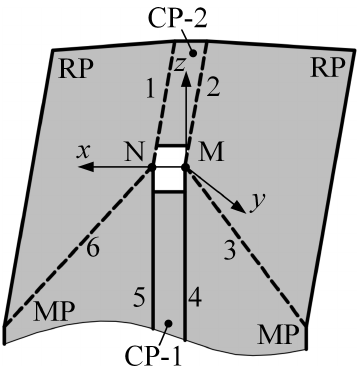
Figure A1. Motion screws and coordinate system M - xyz in U M -A.